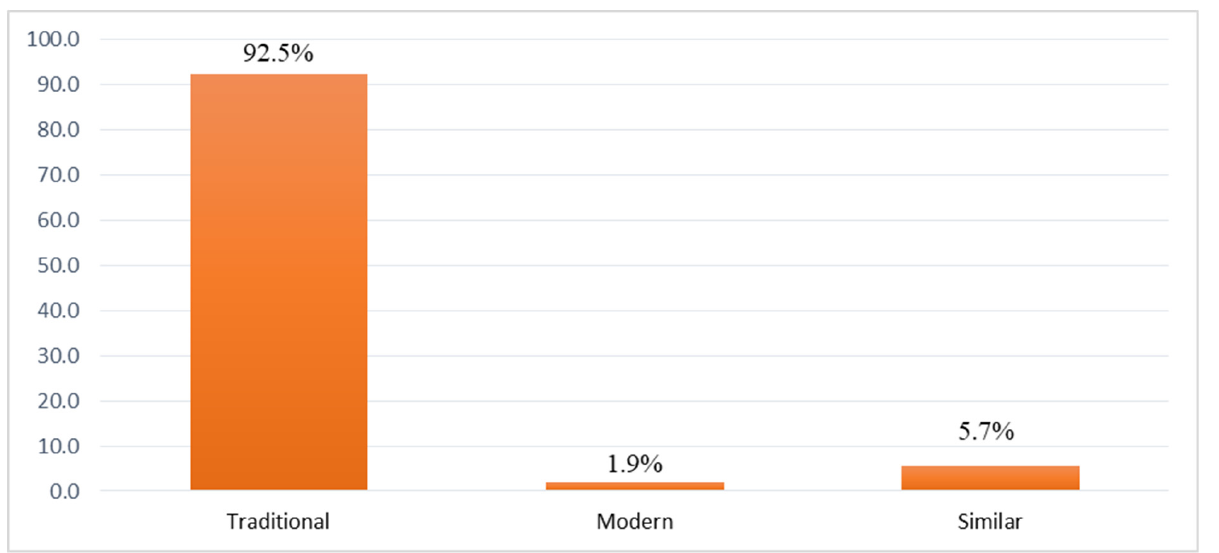
Figure 27. Humidity data from April 2020.